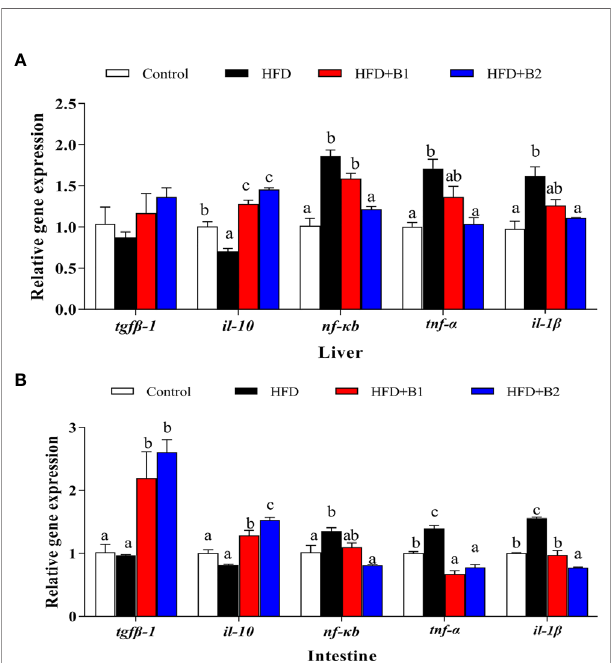
FIGURE 7 | In fl ammation gene expression in liver and intestine of juvenile black seabream ( Acanthopagrus schlegelii ) (% wet weight) fed the experimental diets [Control: 11% crude lipid; HFD: high-fat diet; HFD+B1: HFD +betaine (10g/kg); HFD+B2: HFD + betaine (20 g/kg)] for 8 weeks. (A) The relative mRNA expression of tgf b -1 , il-10 , nf k b , tnf- a and il-1 b in liver. (B) The relative mRNA expression of tgf b -1 , il-10 , nf k b , tnf- a and il-1 b in intestine. Control was used as the reference group, and the mRNA expression levels of target genes were normalized relative to the expression of b -actin . Values are means (n = 3) with standard errors represented by vertical bars. Mean values for the same gene with different letters were signi fi cantly different ( P < 0.05).